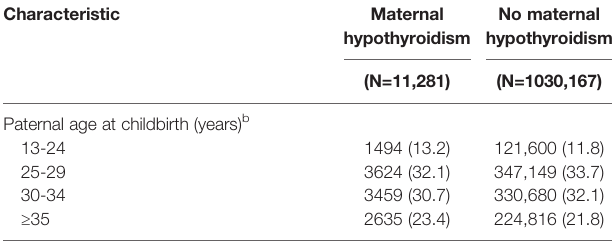
TABLE 1 | Baseline characteristics of the study population according to maternal hypothyroidism, n